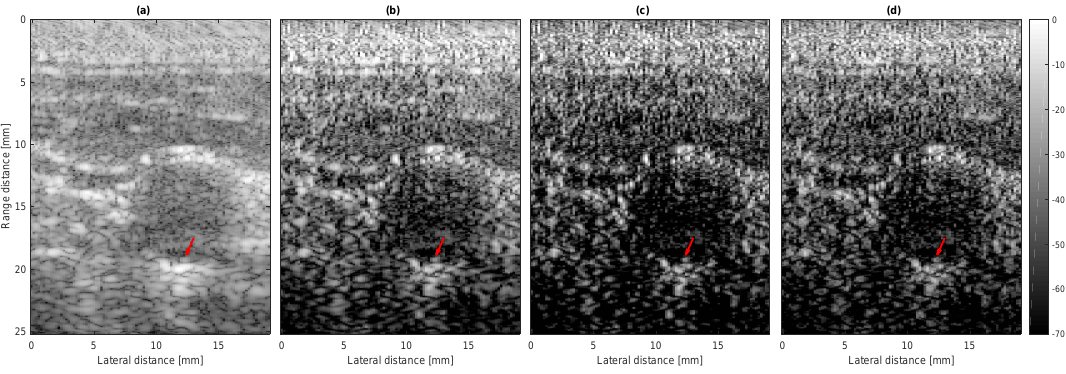
Figure 8. B-mode images of carotid artery obtained ( a ) with DAS; ( b ) with mAPES beamforming without gPCF, and those with gPCFs estimated ( c ) before and ( d ) after applying the beamformer